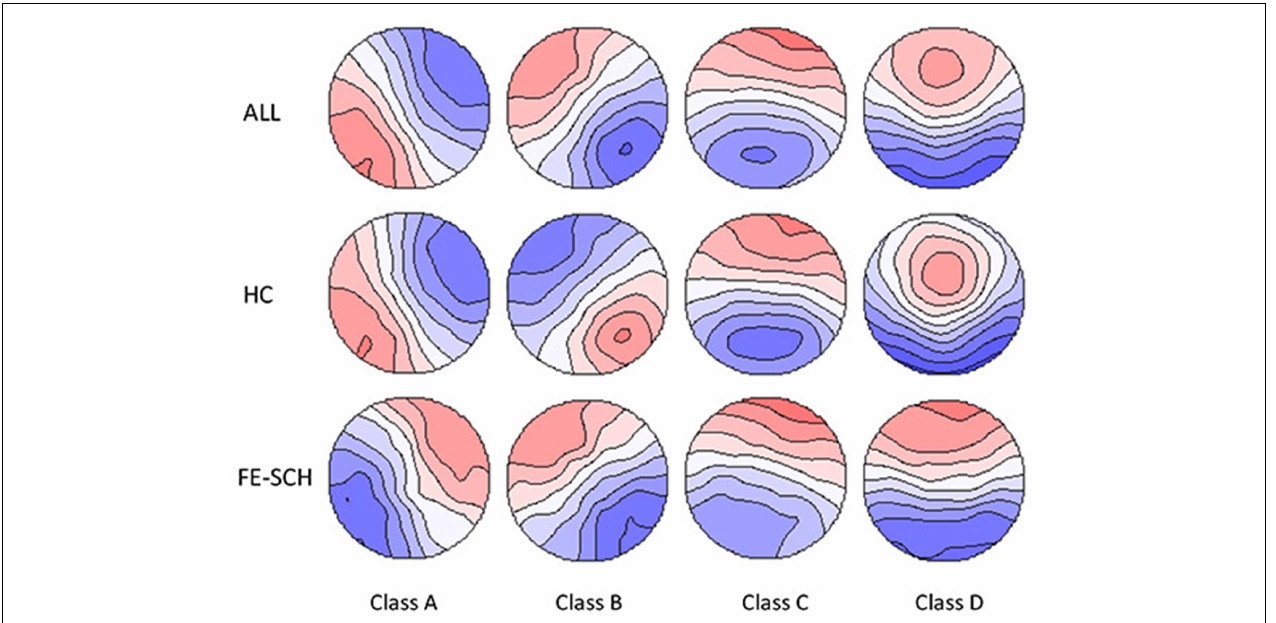
FIGURE 2 | The spatial configuration of the four microstate classes for the two groups and all the participants. FE-SCH, drug-naïve, first-episode schizophrenia; HC, healthy control; ALL, all the participants in this study.